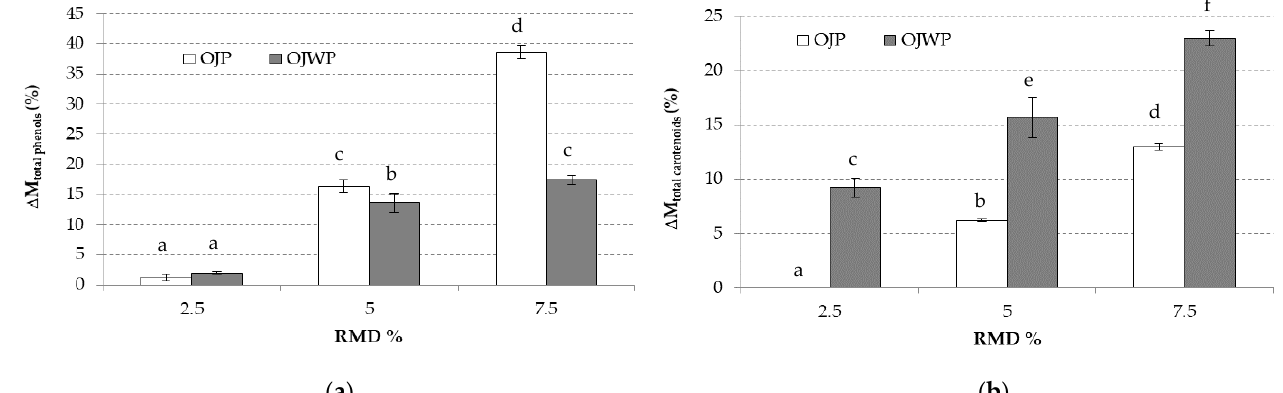
Figure 1. ( a ) Mean values and standard deviation of total phenols variation of pasteurized orange juice (OJP and OJWP) with 2.5, 5, and 7.5 RMD%. ( b ) Mean values and standard deviation of total carotenoids variation of pasteurized orange juice (OJP and OJWP) with 2.5, 5, and 7.5 RMD%. Letters indicate homogeneous groups established by the ANOVA ( p < 0.05) for each parameter analyzed. OJP, orange juice with pulp; OJWP, orange juice without pulp.